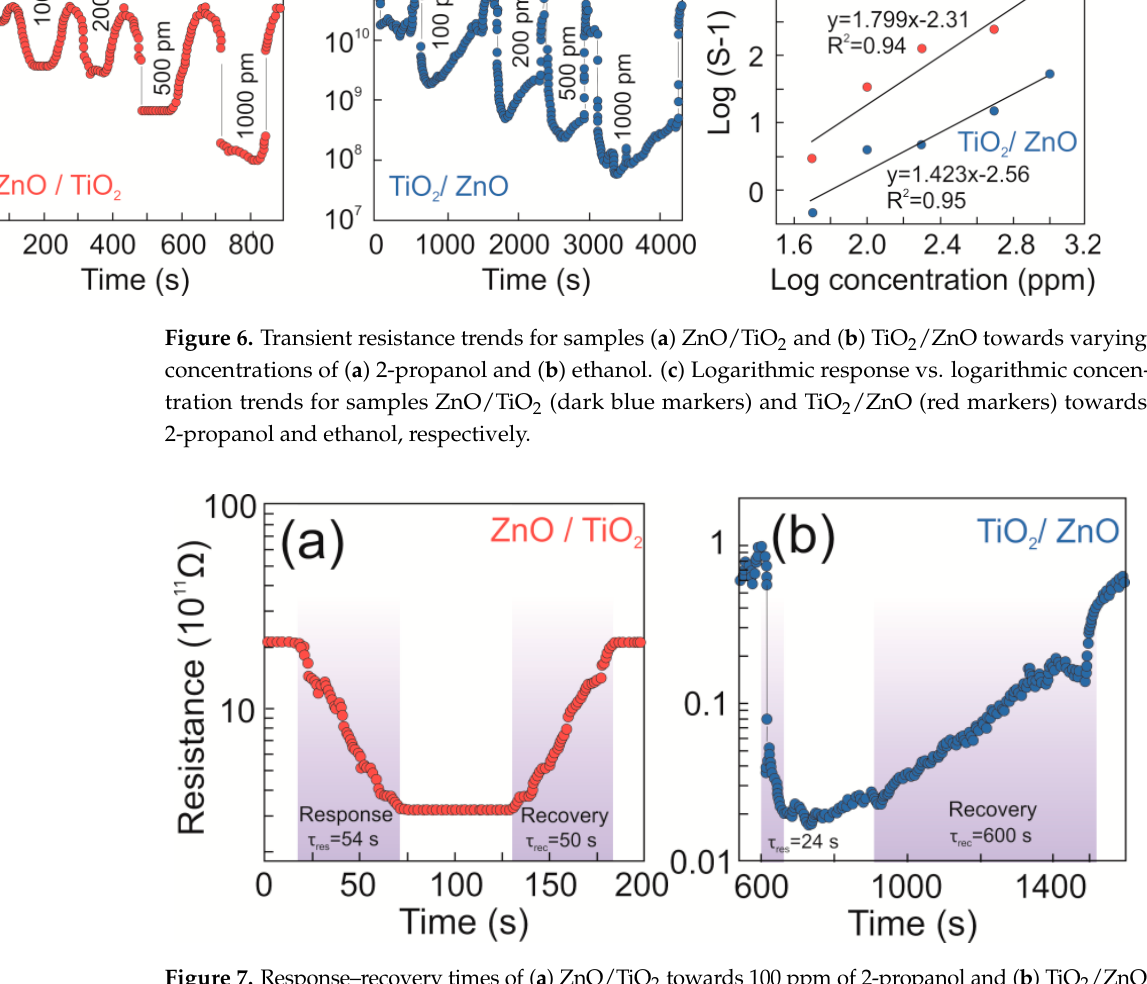
Figure 7. Response–recovery times of ( a ) ZnO/TiO 2 towards 100 ppm of 2-propanol and ( b ) TiO 2 /ZnO towards 100 ppm of ethanol.